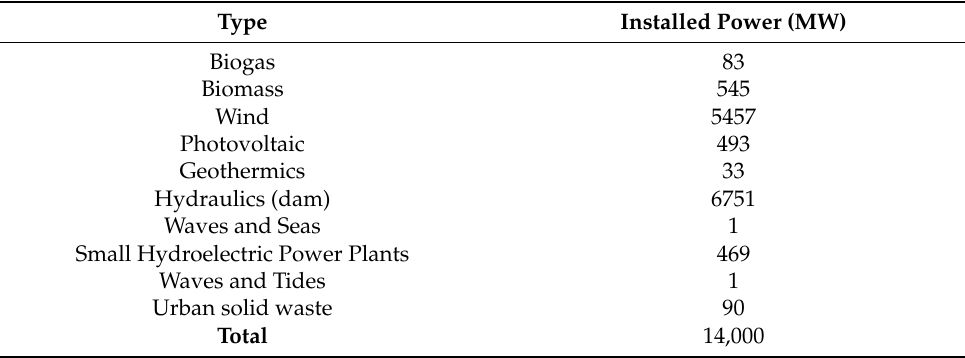
Table 6. Types of renewable power in Portugal